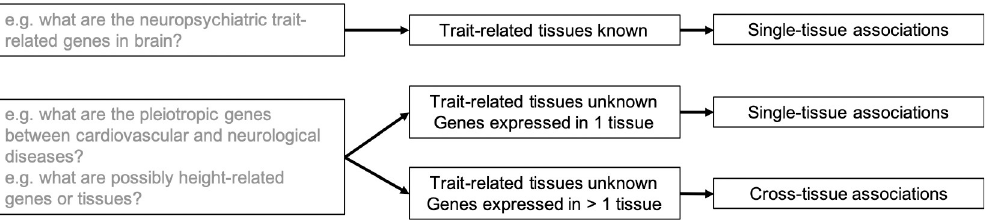
Fig 5. A proposed TSA-TWAS analytic framework that leverages TWAS performance on genes of different tissue specificity properties. The framework proposed based on our simulations is as follows: If trait-related tissue(s) are known for a trait or disease of interest, run single-tissue TWAS, for example, PrediXcan. If trait-related tissue(s) are unknown, run cross-tissue TWAS (UTMOST) on the genes that are expressed in more than one tissue and run single-tissue TWAS (PrediXcan) on the genes that are expressed in one single